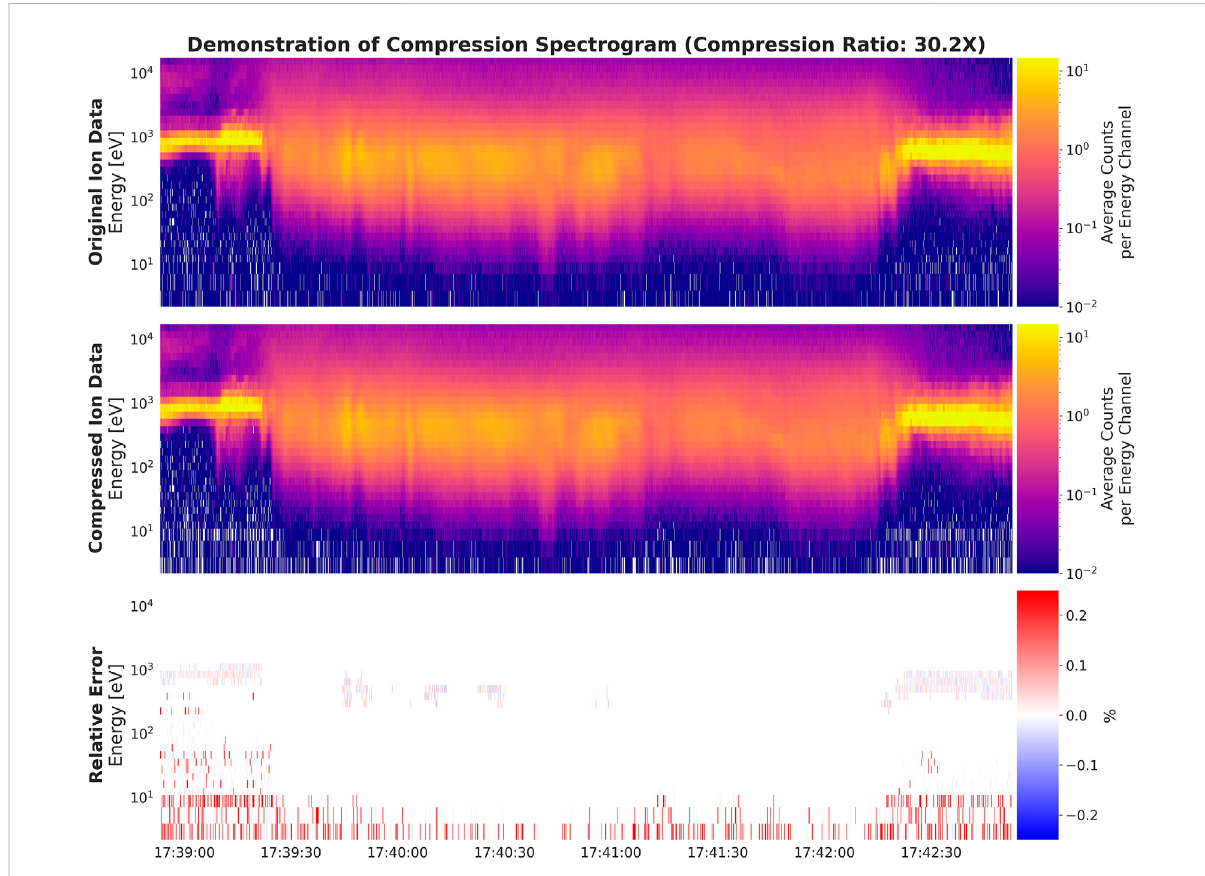
FIGURE 3 Demonstration of the compression algorithm in its end-to-end form displaying the original ion data, the compressed (reconstructed) ion data, andtherelativeerrorbetweenthetwogivenby(original — reconstructed)/original.Thisusesaversionofthemodelwithalatentpatchsizeof n (cid:2) 100 corresponding to DRF (cid:2) .098. In addition to the dimensionality reduction, quantization is used to trim 6 bits off the fractional parts of IEEE 16-bit fl oating point latentrepresentation coef fi cients, andthe GZIP software implementing DEFLATE is used for lossless entropycoding. This interval comes from data measured during the 4B dayside orbital con fi